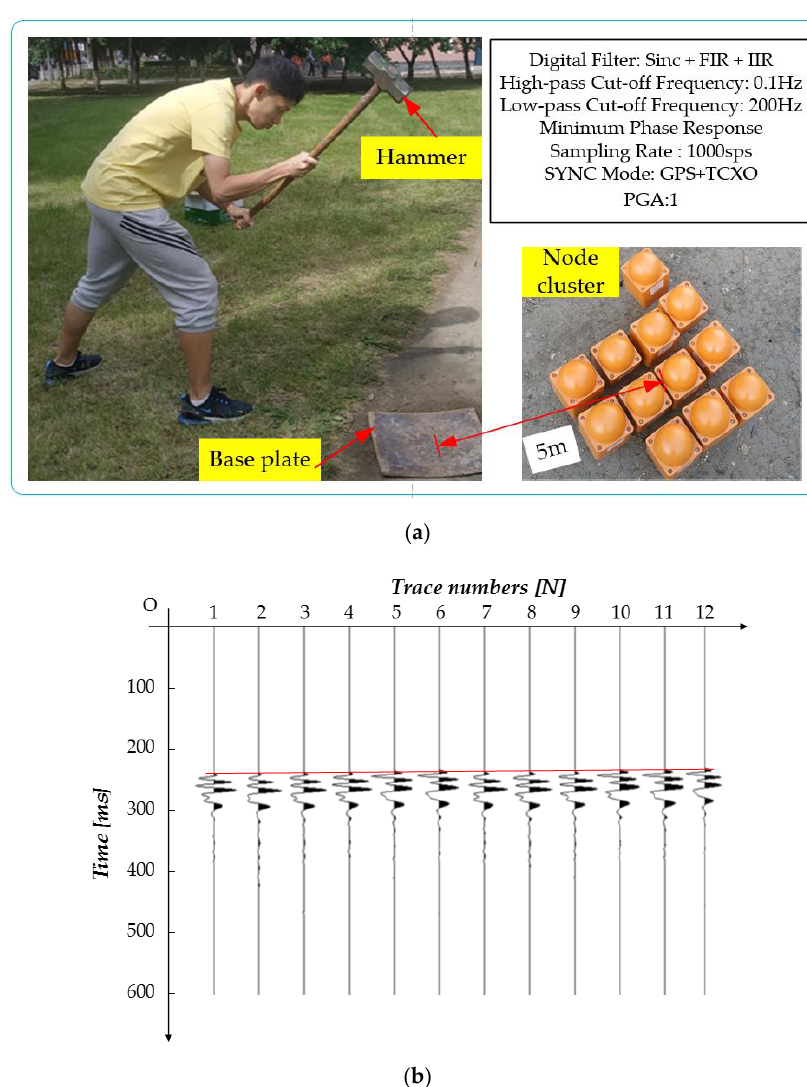
Figure 14. Field measurement with the sensor nodes in a pile ( a ) the sensor nodes are deployed in one field experiment and ( b ) the waveform of the recorded seismic data.